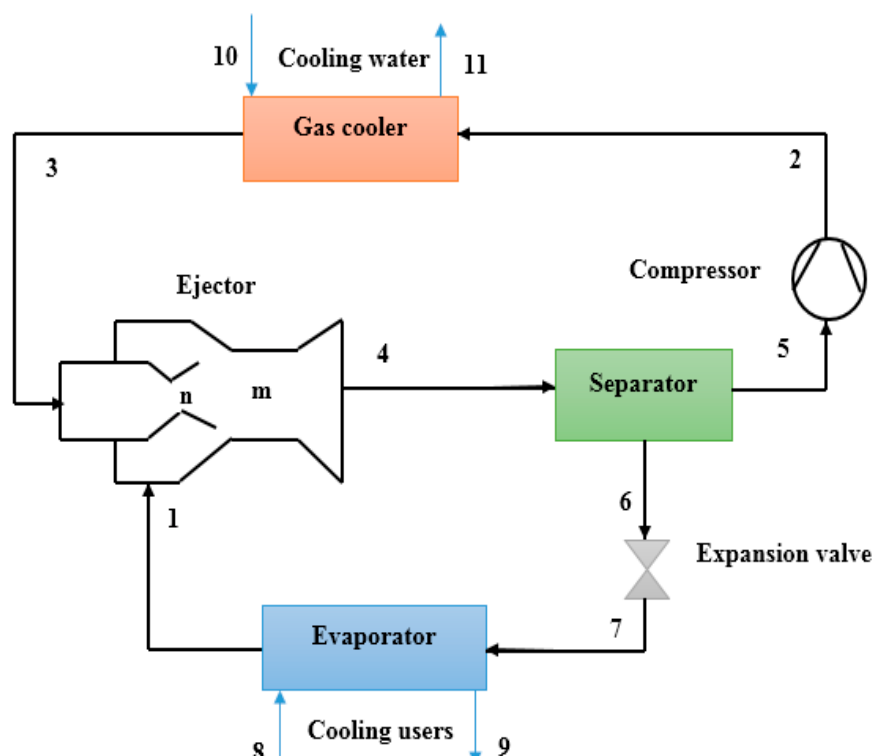
Figure 1. Schematic of the conventional ejector refrigeration cycle (CERC).